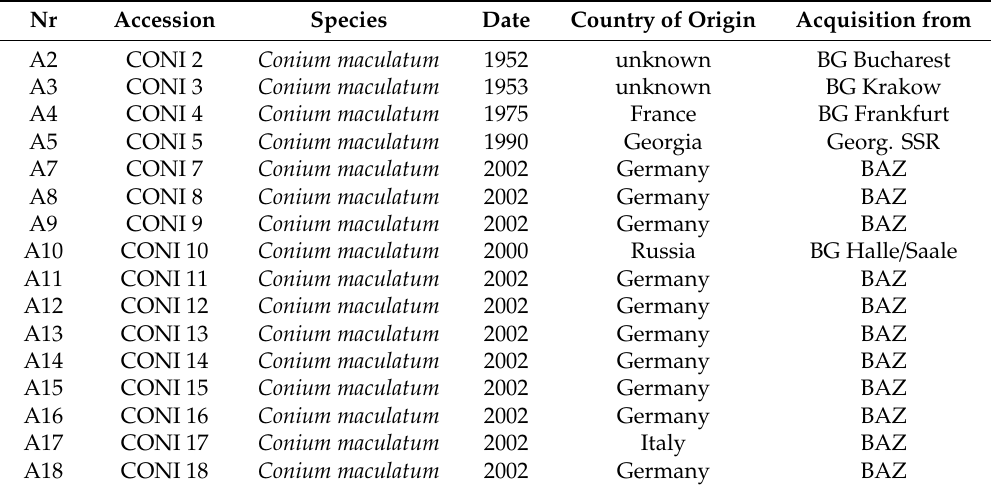
Table 3. List of Conium maculatum accessions from the Leibniz Institute of Plant Genetics and Crop Plant Research